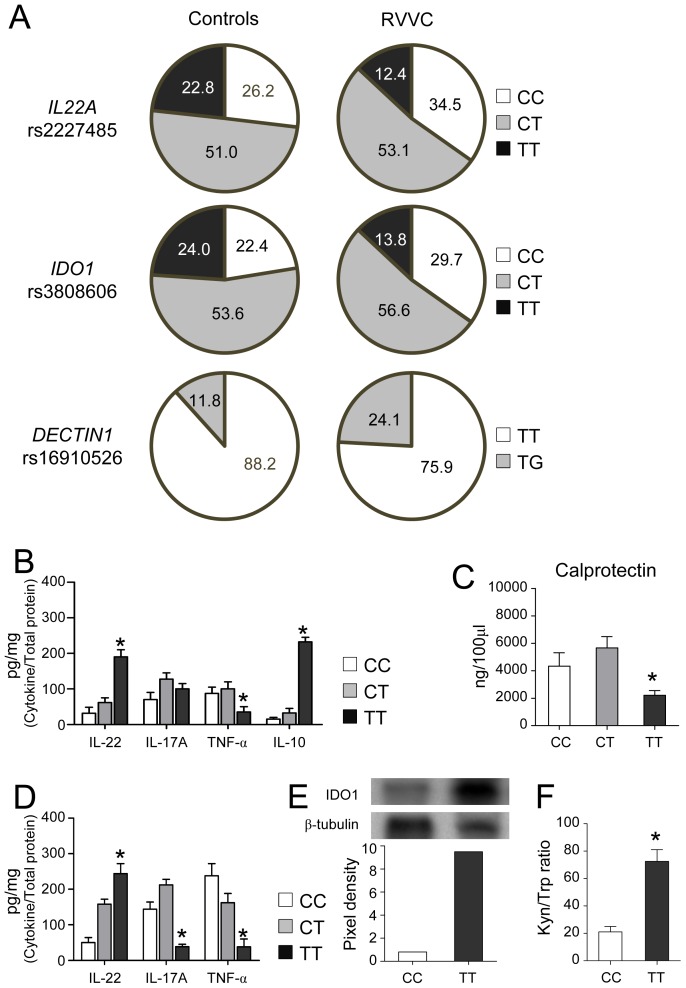
Functional genetic variants in IL22 and IDO1 genes influence susceptibility to RVVC.(A) Frequencies (%) of the different genotypes for single nucleotide polymorphisms (SNPs) in IL22 (rs2227485), IDO1 (rs3808606) and DECTIN1 (rs16910526, Y238X) genes among controls (n = 263) and patients with RVVC (n = 145). (B) Cytokines (pg/mg, cytokine/total proteins) and (C) calprotectin levels (mean values ± s.e.m.) in the vaginal fluids of women bearing the CC, CT or TT genotypes at rs2227485 in IL22. (D) Cytokine levels (pg/mg, cytokine/total proteins, mean values ± s.e.m.) in the vaginal fluids of women bearing the CC, CT or TT genotypes at rs3808606 in IDO1. Data in B, C and D indicate mean values from measurements using samples obtained from at least 10 different women for each genotype, assessed in quadruplicates. (E) IDO protein expression in cells from the vaginal fluids of women bearing the CC or TT genotypes at rs3808606 in IDO1. Western blots of a representative sample out of 10 with similar results are shown along with the corresponding pixel density ratio normalized against β-tubulin. (F) Kynurenine-to-tryptophan (Kyn/Trp) ratios in vaginal fluids of women bearing the CC or TT genotypes at rs3808606 in IDO1. Pooled data from vaginal fluids obtained from at least 10 different women for each genotype. *P<0.05, TT vs. CC genotypes.